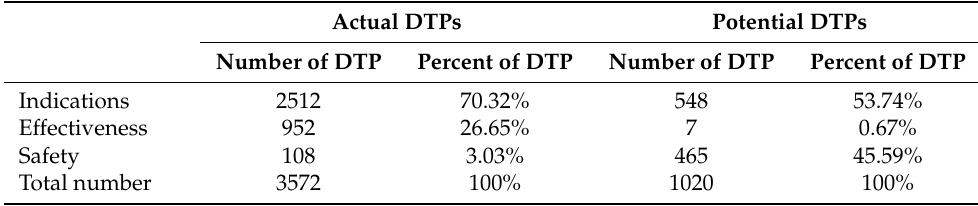
Table 3. Drug-therapy problems